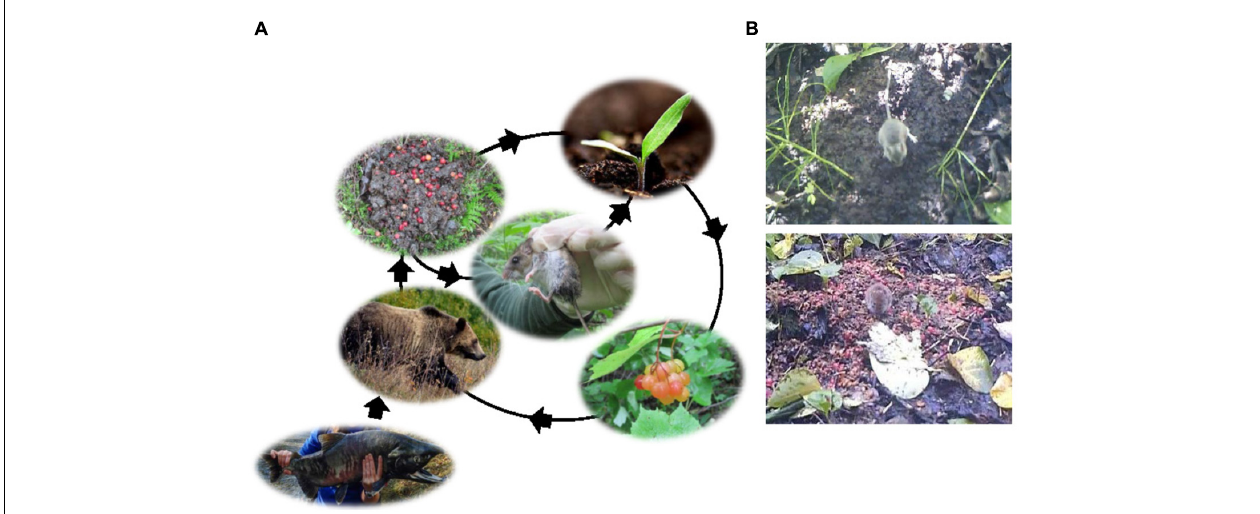
FIGURE 7 | (A) The community relationship between salmon, brown bears, fruit, and northwestern deer mice. Salmon support bears that act as seed dispersers and provision small mammals with seed-filled bear scats. Deer mice then act as secondary seed dispersers. The northern red-backed vole (not shown) is a larder-hoarder and is not expected to significantly aid in seed dispersal of fruiting plants. (B) The northwestern deer mouse (top) and the northern red-backed vole (bottom) feeding on seed-filled bear scats (Source: Shakeri et al., 2018).